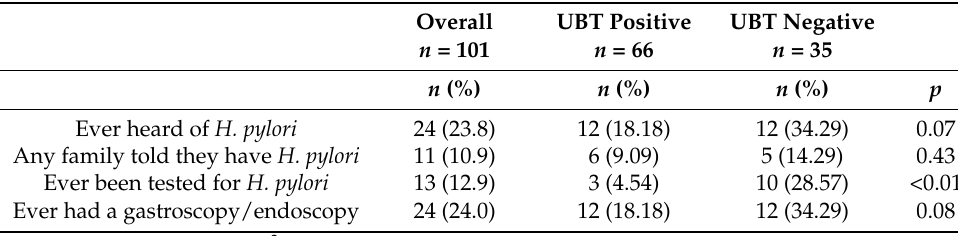
Table 3. Differences in self-reported H. pylori awareness by H. pylori infection status as measured by urea breath test